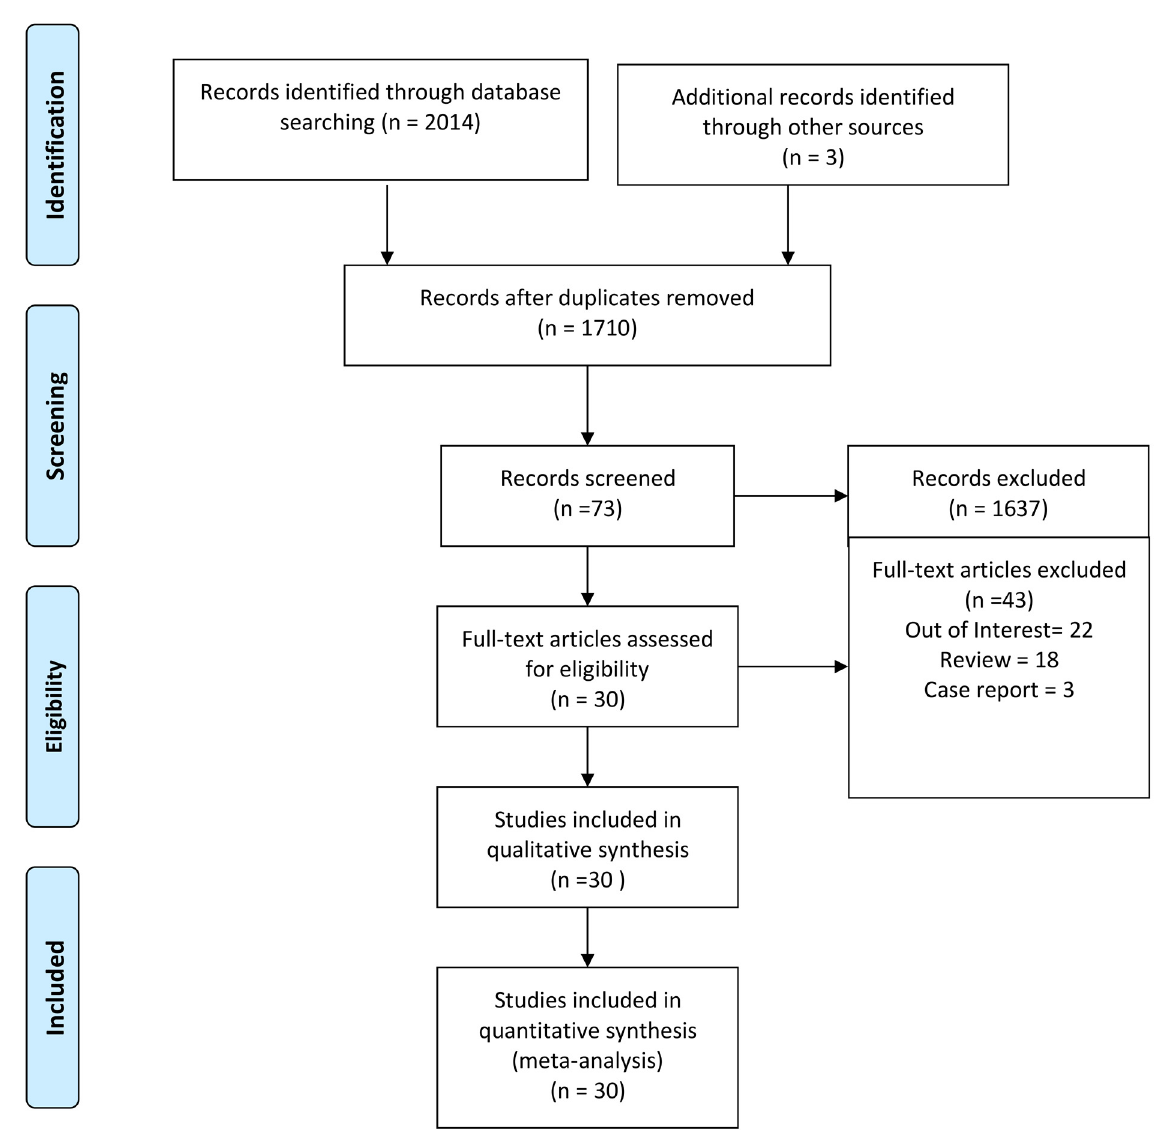
Figure 1. PRISMA 2009 flow diagram